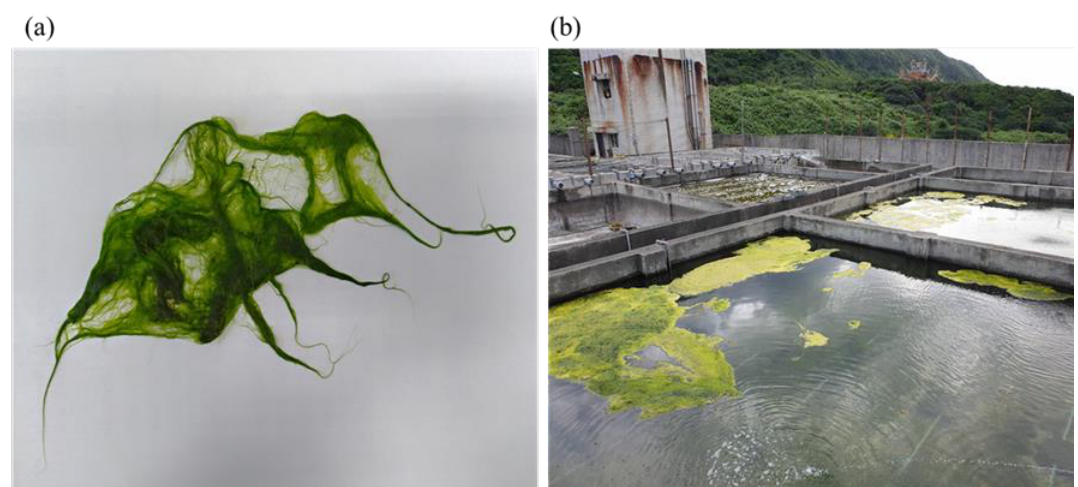
Figure 1. Rhizoclonium samples collected from aquaculture ponds: ( a ) green macroalgae Rhizoclonium ; ( b ) Rhizoclonium growth in aquaculture ponds.